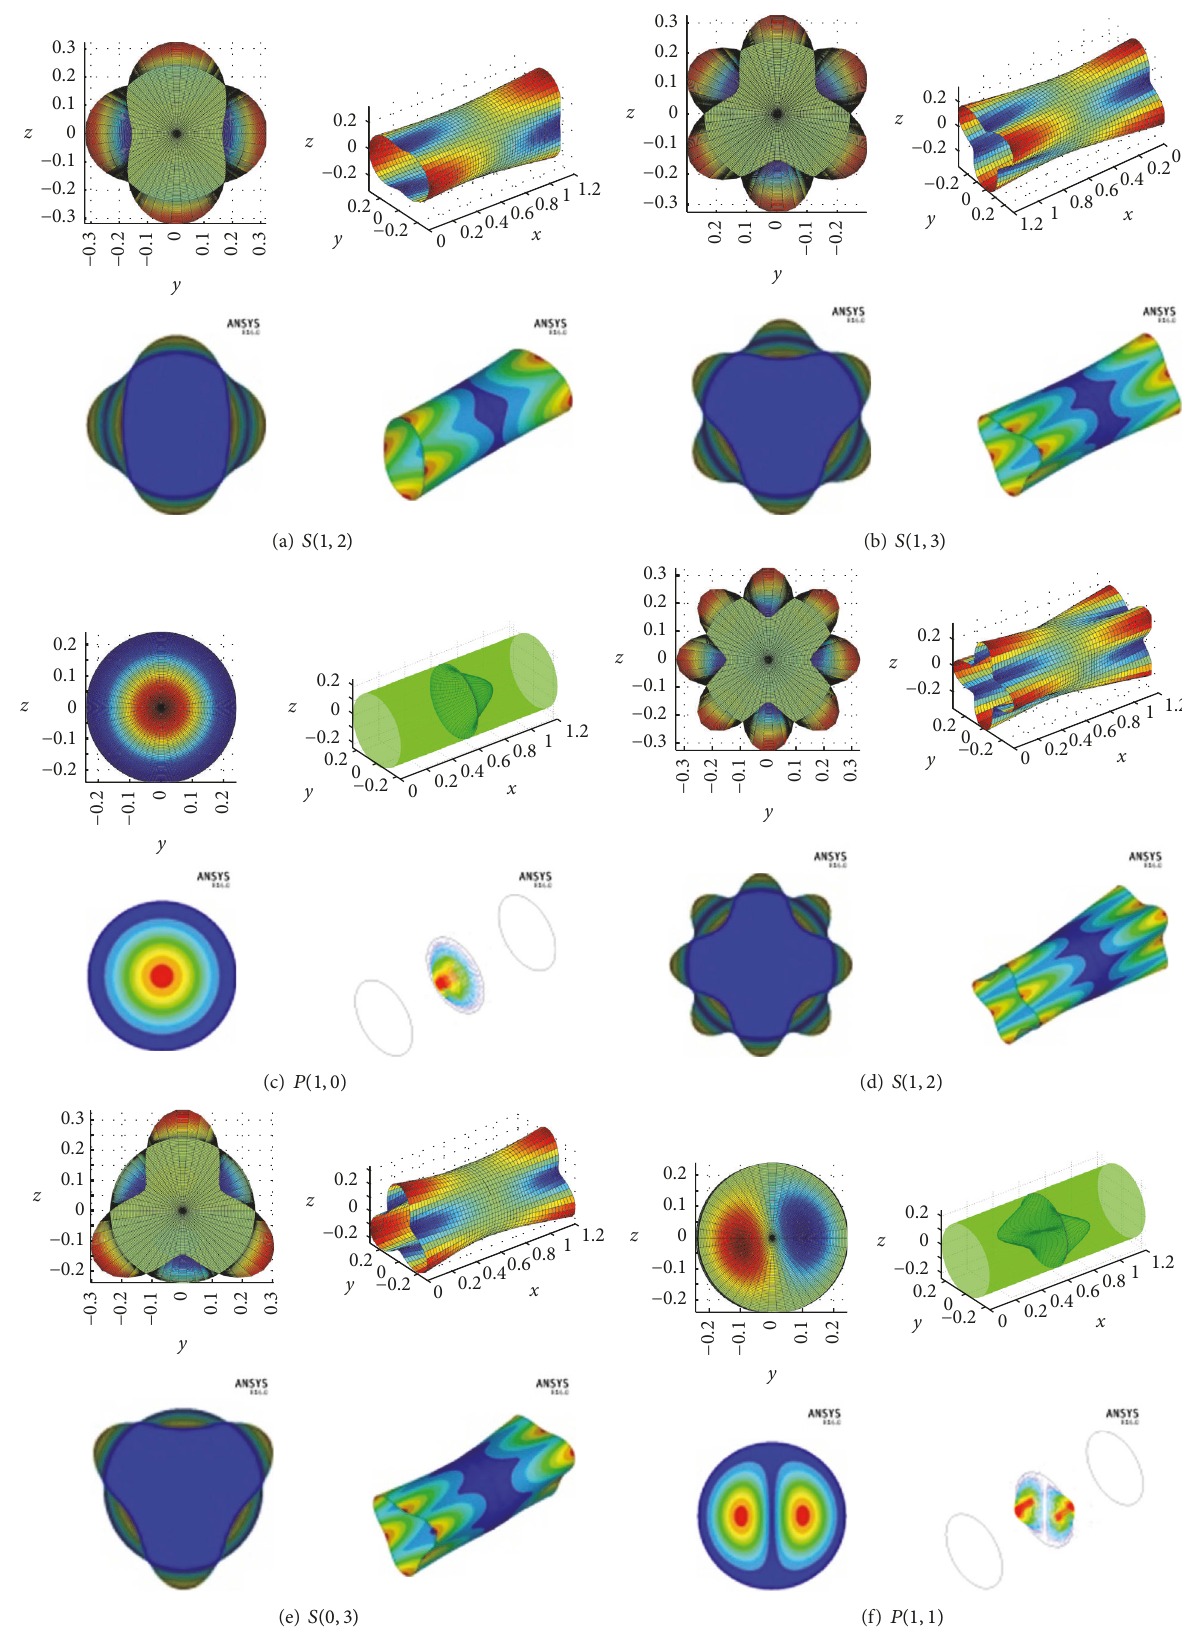
Figure 2: The modes of coupled structures with